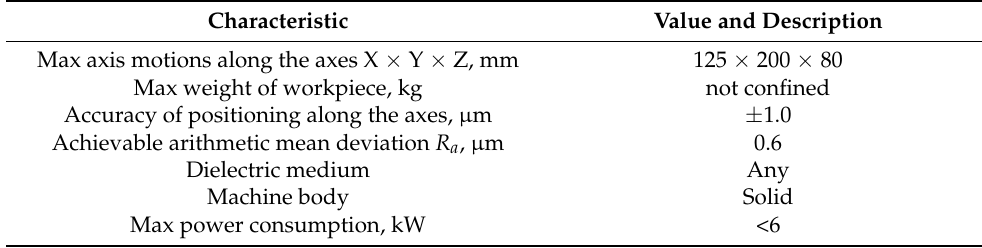
Table 1. Main characteristics of an ARTA 123 Pro wire electrical discharge machine.